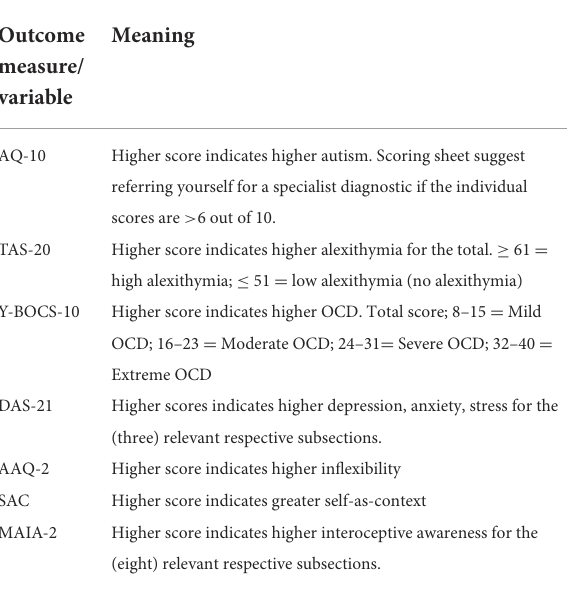
TABLE 1 Index of measurement score